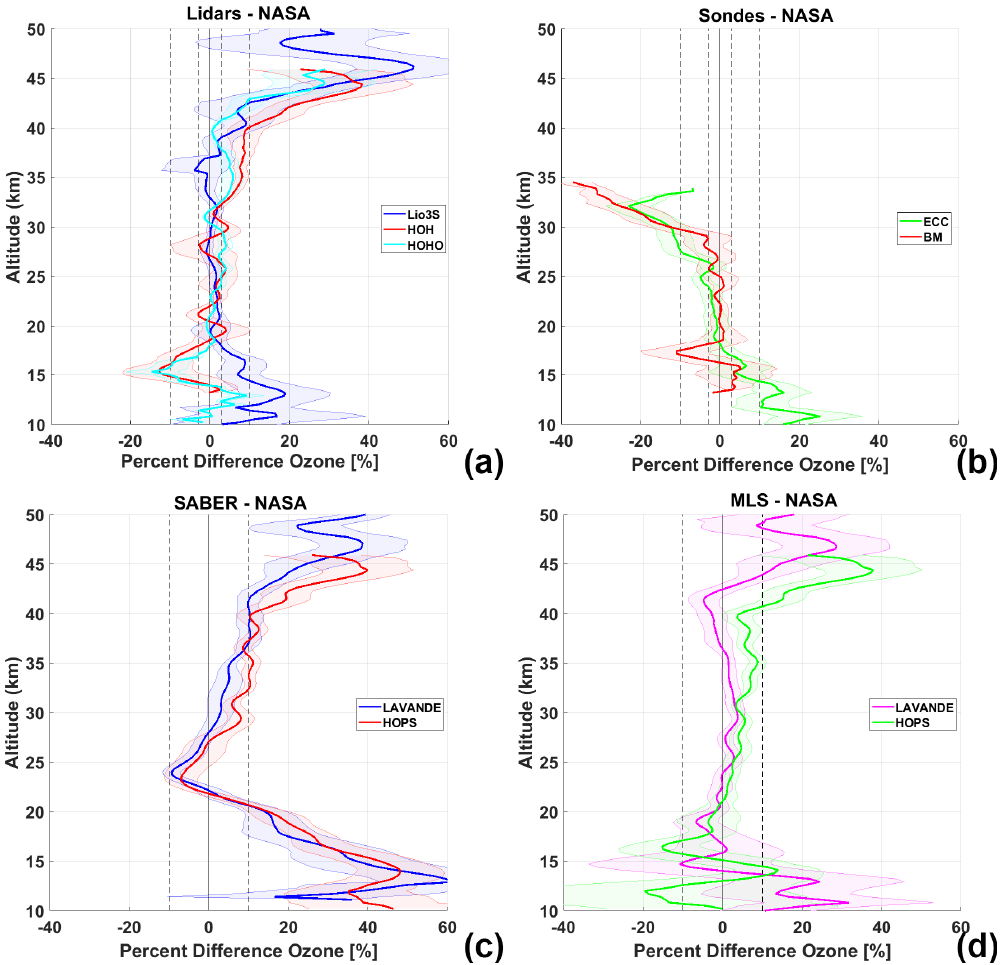
Figure 19. Cross-comparison of LAVANDE and HOPS temperature measurements for the LiO 3 S, LTA, HOH, and HOHO NDACC lidars, MLS and SABER satellites, and the radiosondes attached to the Brewer–Mast (RS92-SGP) and ECC (MeteoModem M10), with respect to the NASA-STROZ